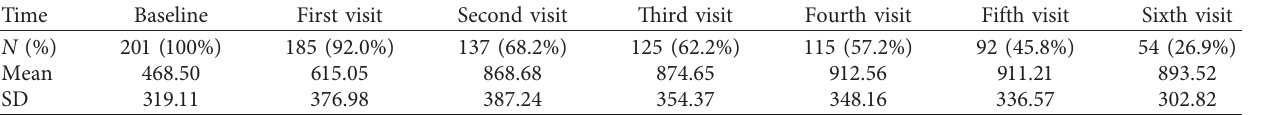
Table 1: Summary statistics of the longitudinal CD4 cell count of HIV-infected children in different follow-up months. Time